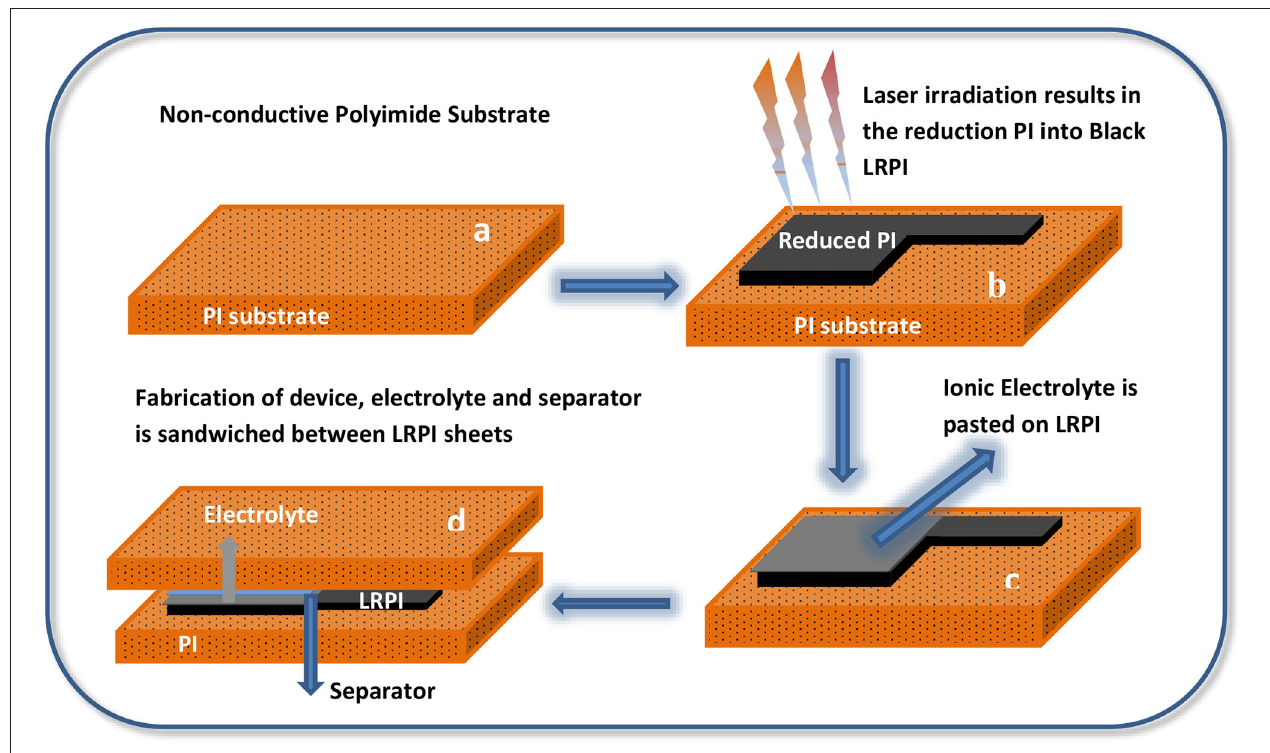
FIGURE 1 | (a–d) Schematic Diagrams showing fabrication steps of supercapacitor (b) shows image of PI and LRPI material which clearly shows that the PI material surface is altered after laser irradiation. (c) Ionic electrolyte is pasted on the reduced part of PI sheet to fabricate an electrode. (d) Separator is sandwiched between two electrodes to make an EDLC.